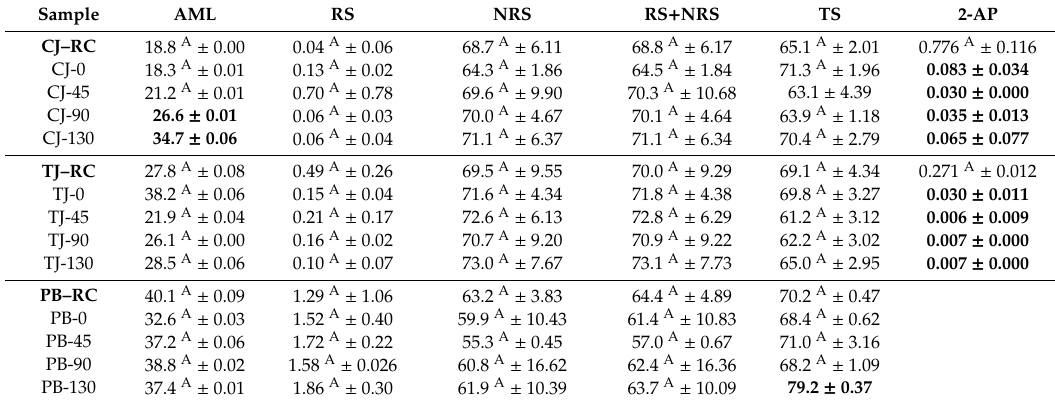
Table 2. Starch and aroma quality attributes of rice cooker and retort processed rice 1,2